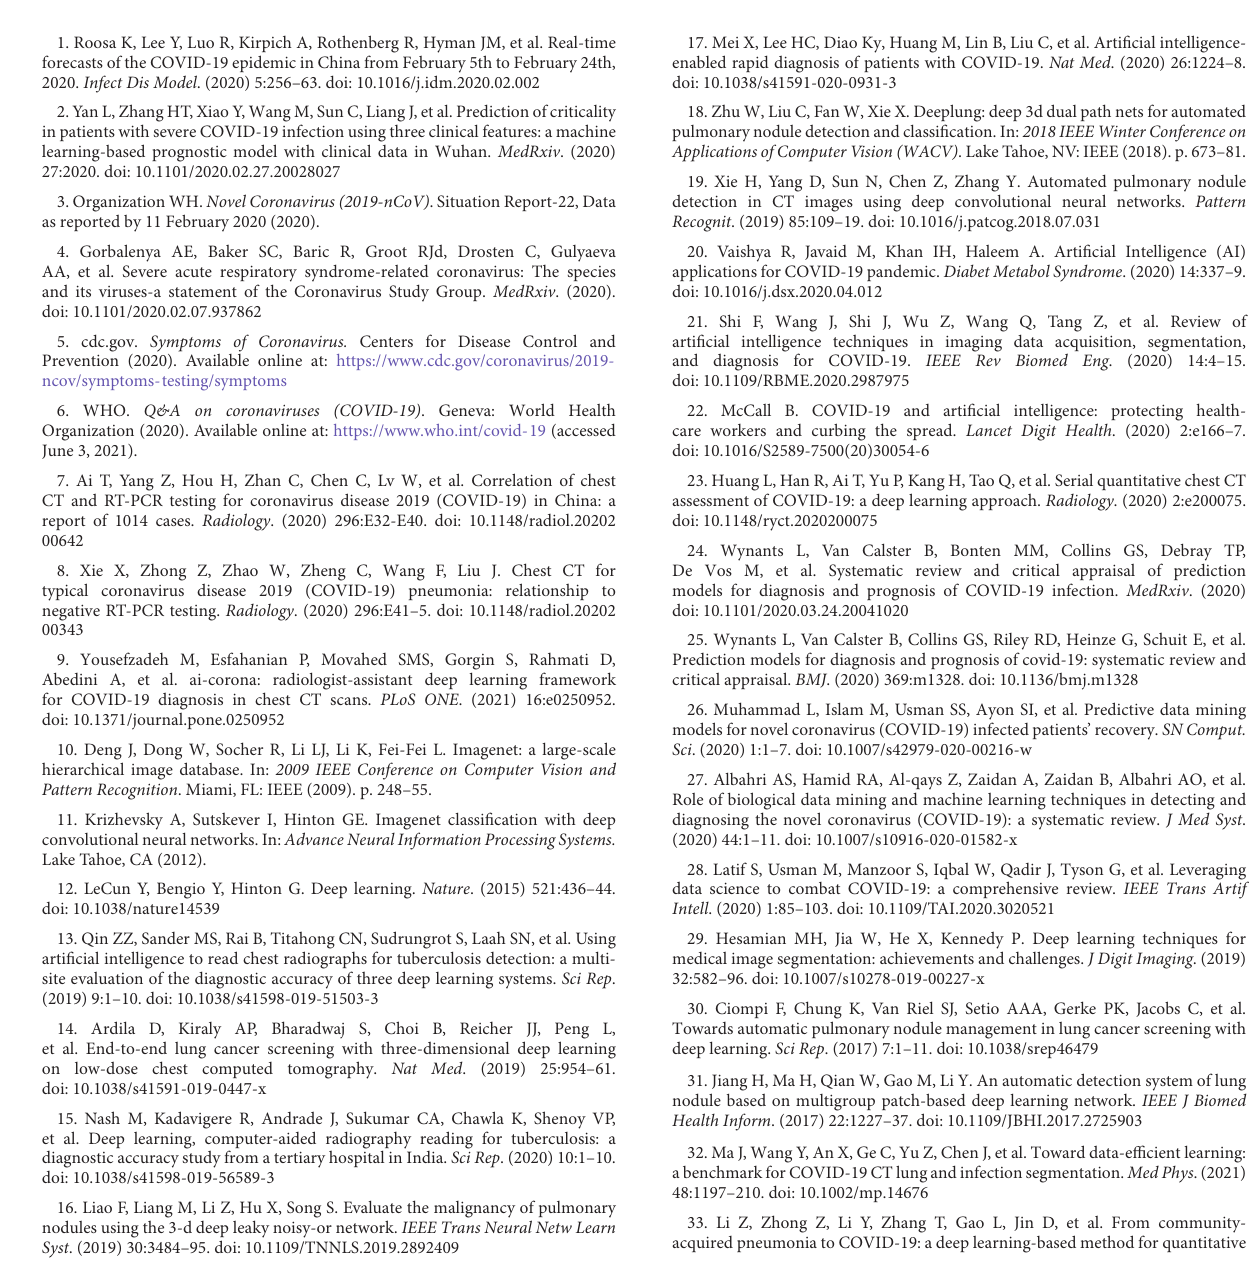
SUPPLEMENTARYFIGURE2 Number of normal and infected slices of the data used in the train and validation sets. SUPPLEMENTARYFIGURE3 Slice infection percentage in the train and validation sets. SUPPLEMENTARYFIGURE4 Sample count of different classes of infection severity for the 5 lung lobes and overall.